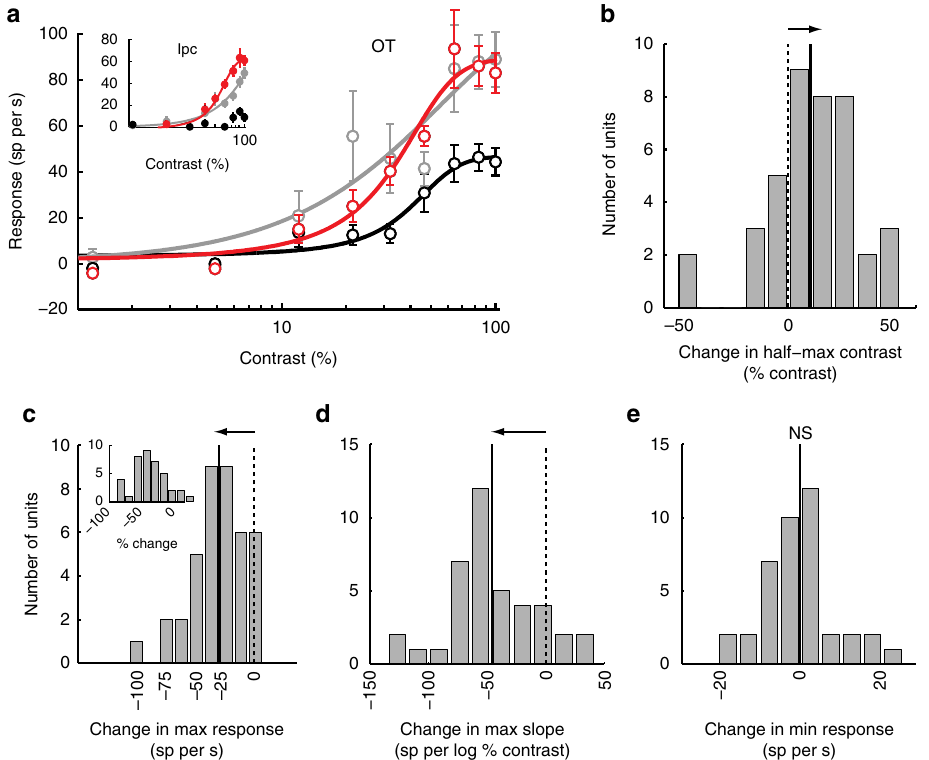
Figure 7 | Effect of Ipc blockade on contrast-response functions in the OT for aligned OT–Ipc sites. ( a ) Data from a single OT–Ipc pair. The graph shows the responses (mean and s.e.m.) of an OT unit to various contrasts of a dark looming-dot stimulus (8 (cid:2) per s) before (red), during (black) and after (grey) iontophoretic application of kyn at the Ipc site. The inset shows the data recorded simultaneously from the Ipc injection site, and it uses the same colour code. Curves are best-fit sigmoidal functions (Methods). ( b – e ) Population summaries ( n ¼ 40) of values derived from best-fit sigmoidal functions. Inset shows per cent changes. Dashed vertical line indicates zero change; solid vertical line indicates mean change; horizontal arrow indicates significant shift from zero ( P o 0.05; paired t -test). In e , the mean change was zero.